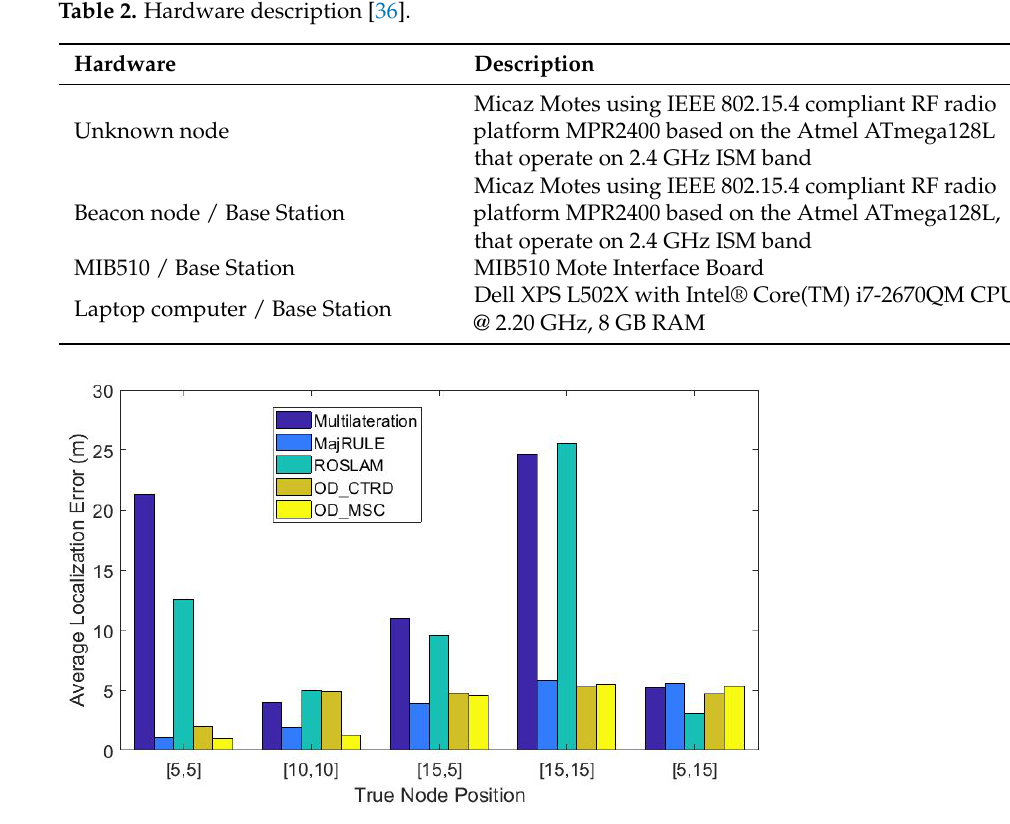
Figure 18. Performance evaluation of all five localization schemes using experimental data to localize five unknown nodes. Table 3. Average RSSI values received by the mobile beacon node from unknown nodes 1 to 5